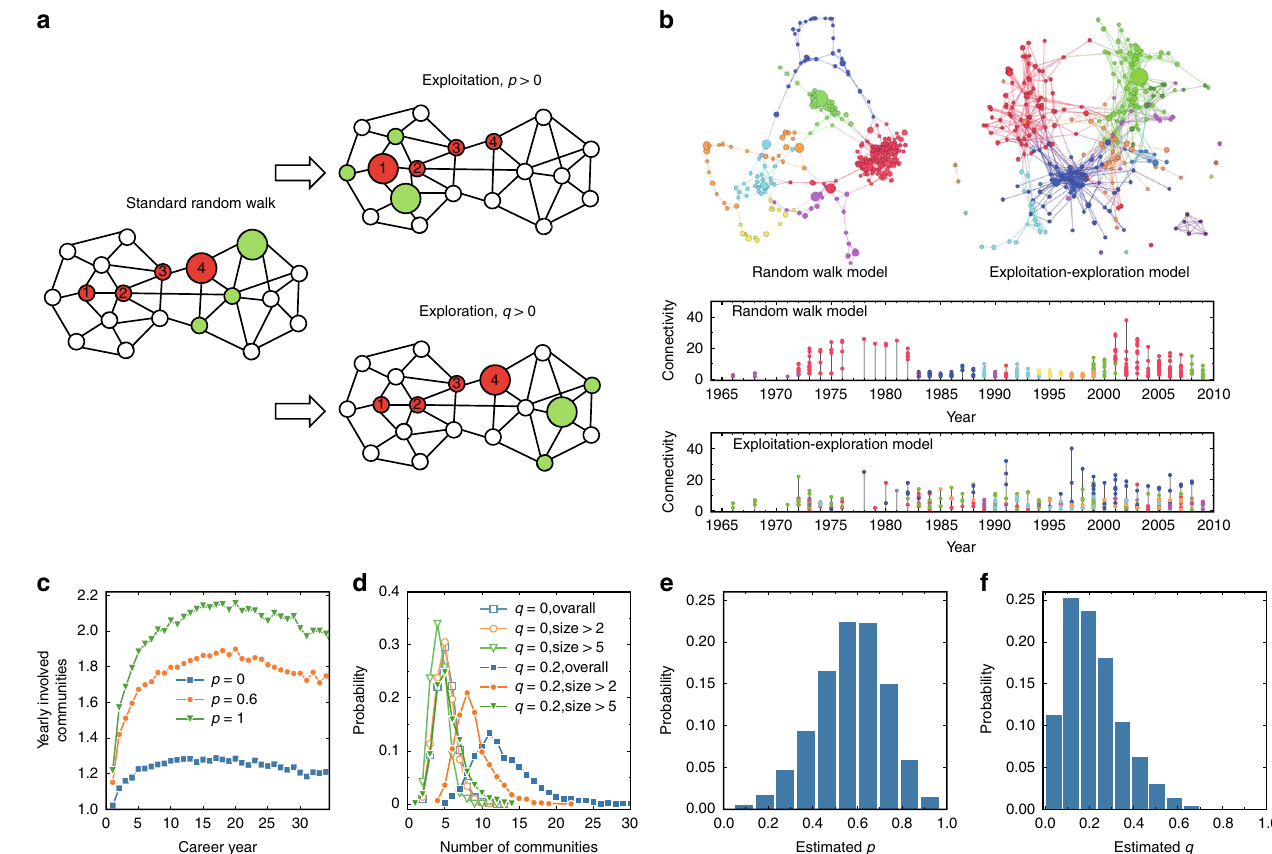
Fig. 5 Performance of the exploitation – exploration model (EEM). a Illustration of the EEM. The research activity is modeled as a node activation process in the knowledge space. When a scientist publishes a paper, she activates a node (i.e., a new knowledge) in the knowledge space. The network activated by this scientist at the end forms her personal network recording all her papers and the relations between them. The underlying toy network is a demonstration of the knowledge space, and the red nodes are the nodes already activated by a scientist, with a number recording the step in which the node is activated. The simplest model for the node activation process is the standard random walk, assuming that a scientist randomly activates a neighboring node of the last activated node. Therefore, one of the neighboring nodes (marked in green with a bigger size) of the red node 4 will be randomly picked and activated. In the EEM, we introduce an exploitation process and an exploration process. With probability p , the scientist randomly re- exploits the neighborhood of one of the previously activated nodes. In the fi gure, the scientist makes exploitation by jumping back to the red node 1 and randomly activating one of its neighbors. With probability q , the scientist explores nodes beyond the closest neighbors of node 4. For simplicity, we assume that the scientist randomly activates in the exploration step a next-nearest neighbor. b Comparison of the co-citing networks (CCN) as well as the paper publishing time series generated by the random walk model and by the EEM. The parameters including the initial paper and the number of papers in each year are set the same as in Fig. 1. In ( c , d ), these parameters are of all analyzed authors. c The number of yearly involved communities for different p , while q = 0. d The distribution of the number of communities that each scientist is involved during her career for different q . e , f Estimation of the probability p and q of each scientist based on the real data, plotted as their probability density